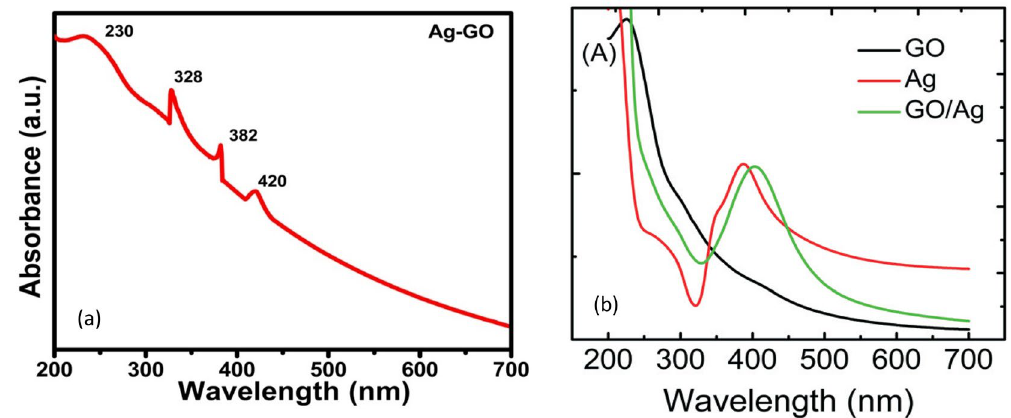
Figure 1. ( a ) UV–Vis spectra of Ag–GO sample ( b ) UV–Vis spectra of GO and Ag–GO reported in Ref. 17